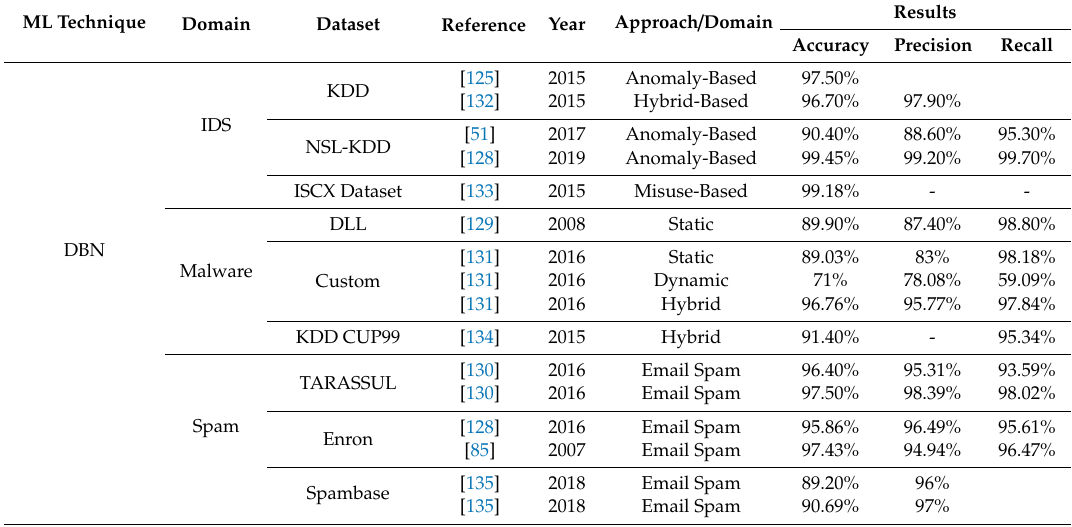
Table 6. Evaluation of DBN in Cybersecurity.